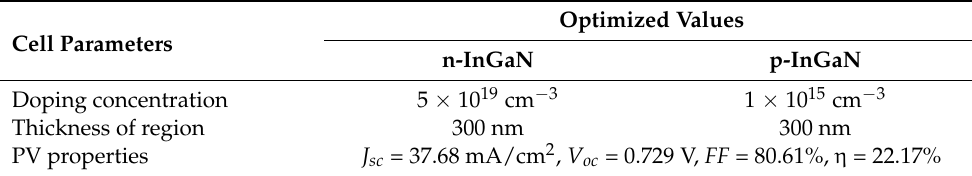
Table 3. Reported electrical properties of InGaN solar